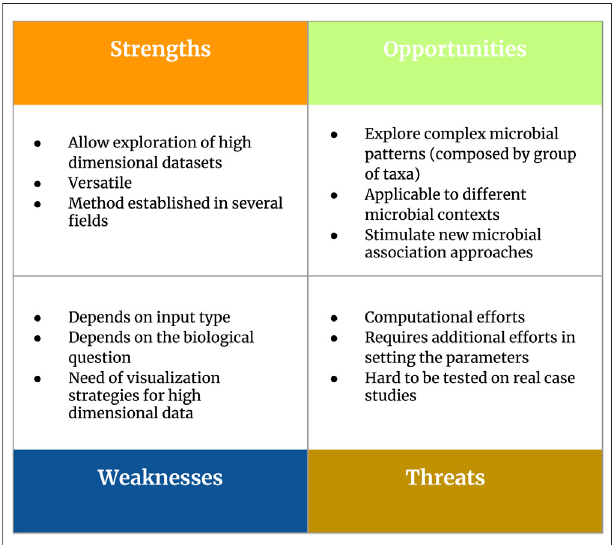
FIGURE 5 | Overview of the main strengths, weaknesses, opportunities and threats (SWOT analysis) related to the use of frequent itemset mining as a tool for microbiome pattern